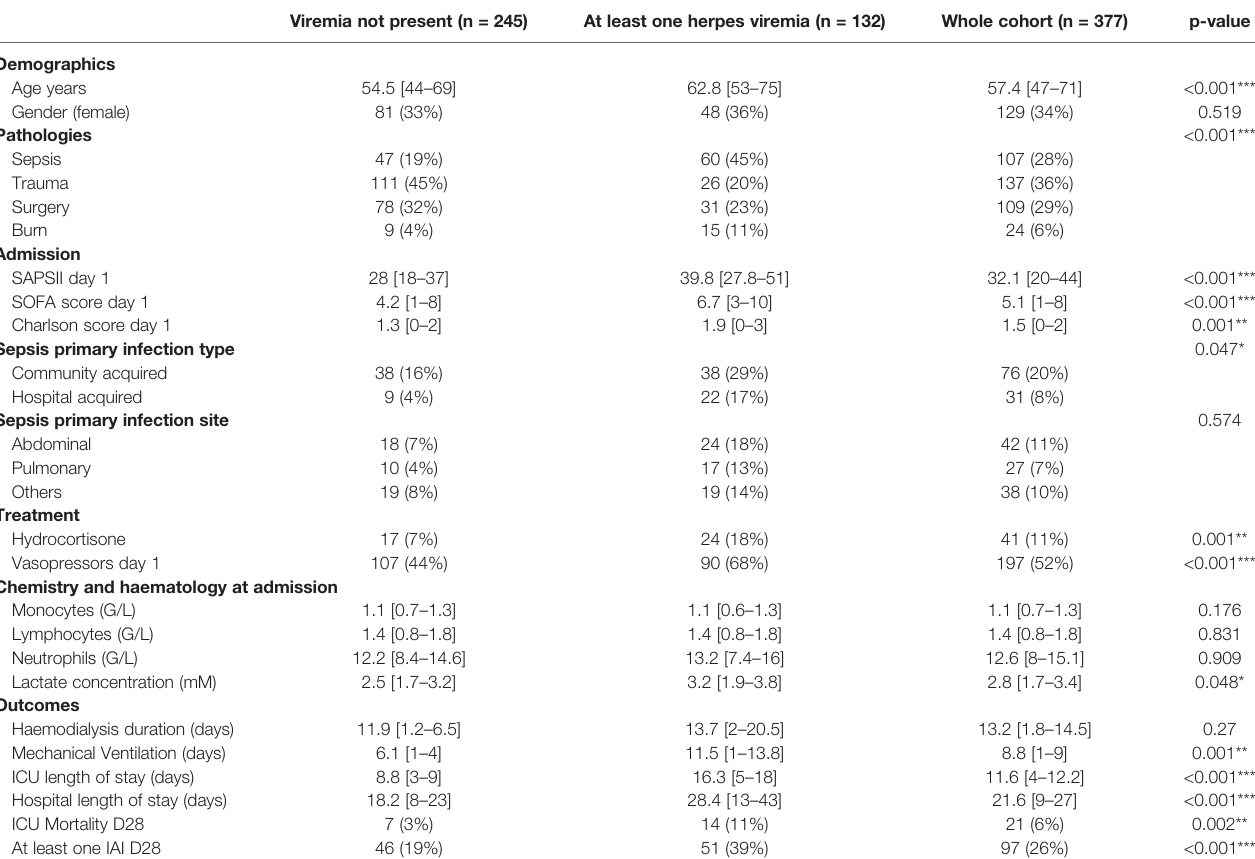
TABLE 1 | ICU patient characteristics at admission and outcomes according to herpesvirus viral DNAemia during the fi rst month (D1 – D28) in ICU (excluding TTV). Viremia not present (n = 245) At least one herpes viremia (n =